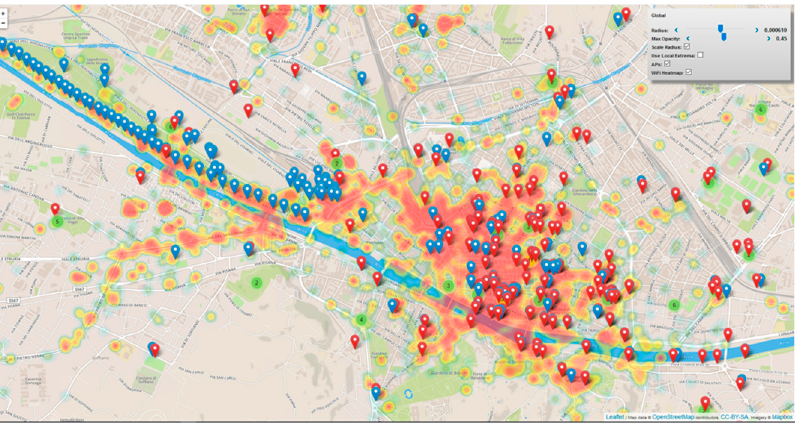
Figure 7. Florence heat-map. This heatmap put in spatial relation city users’ most patronized places with the position of the 1500 Wi-Fi APs of the whole network (using a color gradient scale to discriminate between different densities of measures).